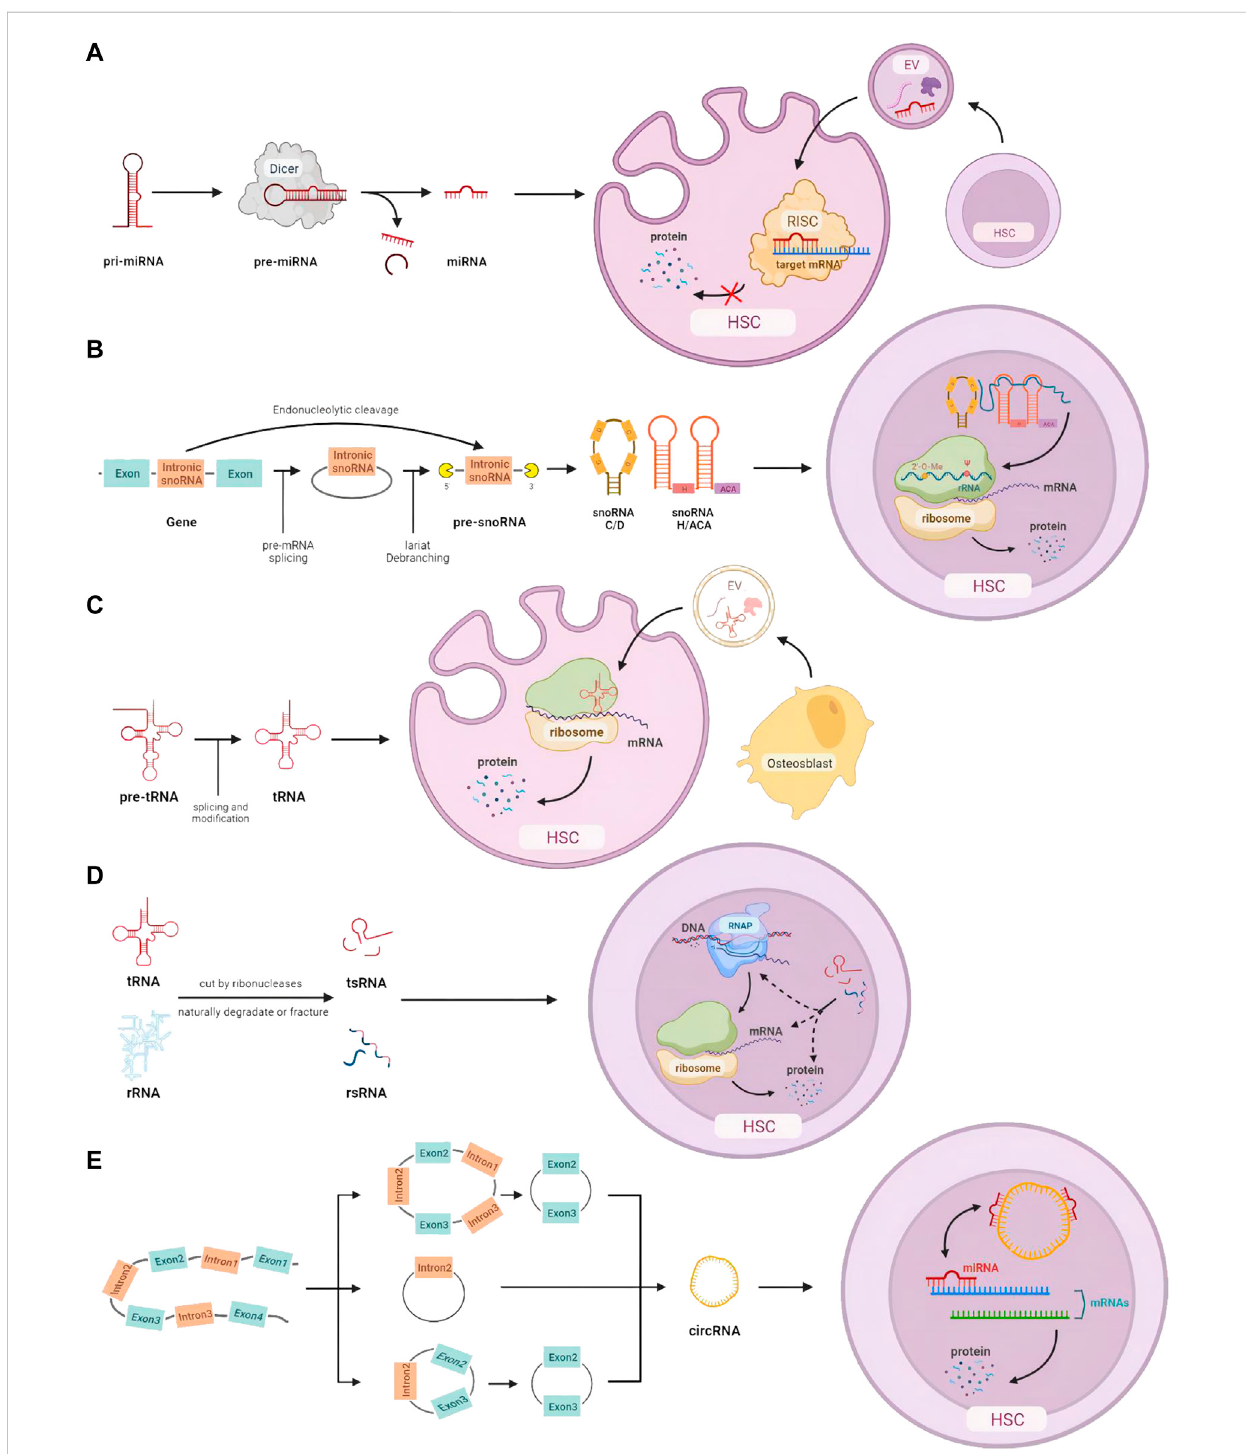
FIGURE 1 HSC homeostasis is regulated by small non-coding RNAs: (A) miRNA processing, intercellular transmission, and intracellular regulation of mRNA expression. (B) snoRNA processing and its function on rRNA modi fi cation. (C) tRNA processing, intercellular communication, and translation-related intracellularaction. (D) TheoriginoftsRNAandrsRNA,andtheirpotentialcontrolattheDNA,RNA,andproteinlevels. (E) Differentcleavageformationsof circRNA and its effects on